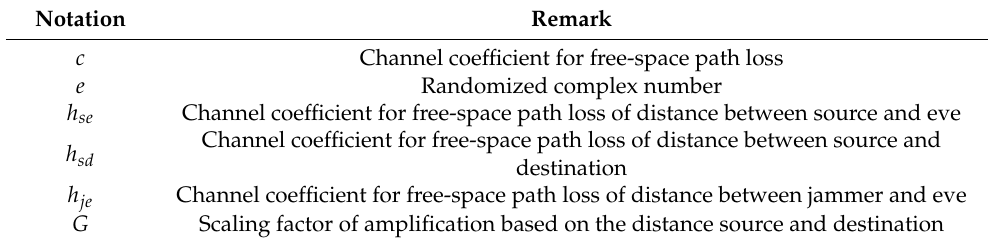
Table 4. Defined parameters for pseudo-code.